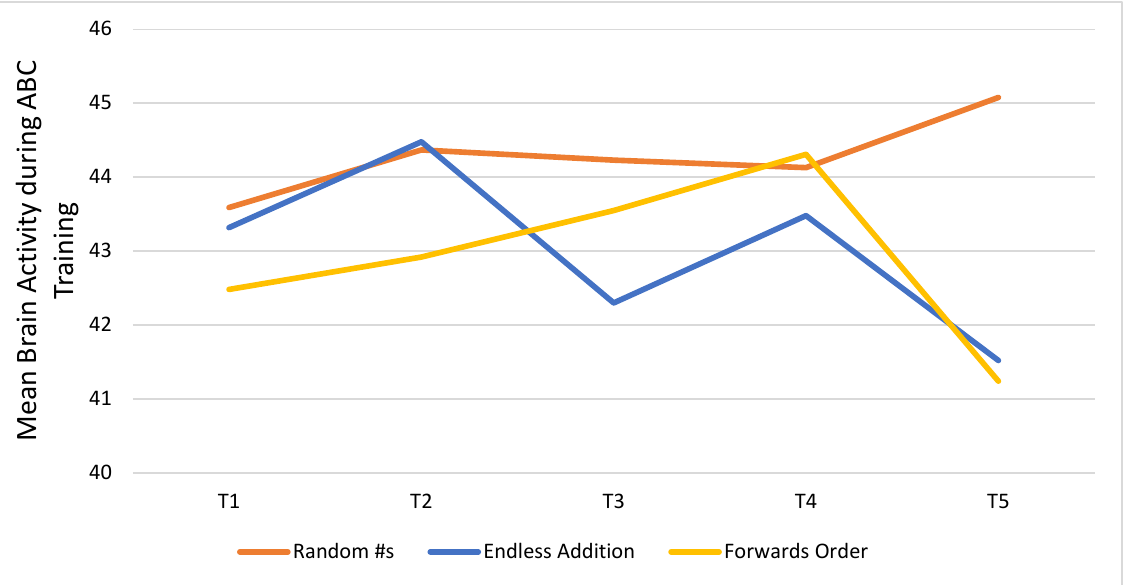
Figure 5. Trend in brain activity for every 5 days of cognitive training for the treatment (ABC) group, shown separately for each ABC game played.